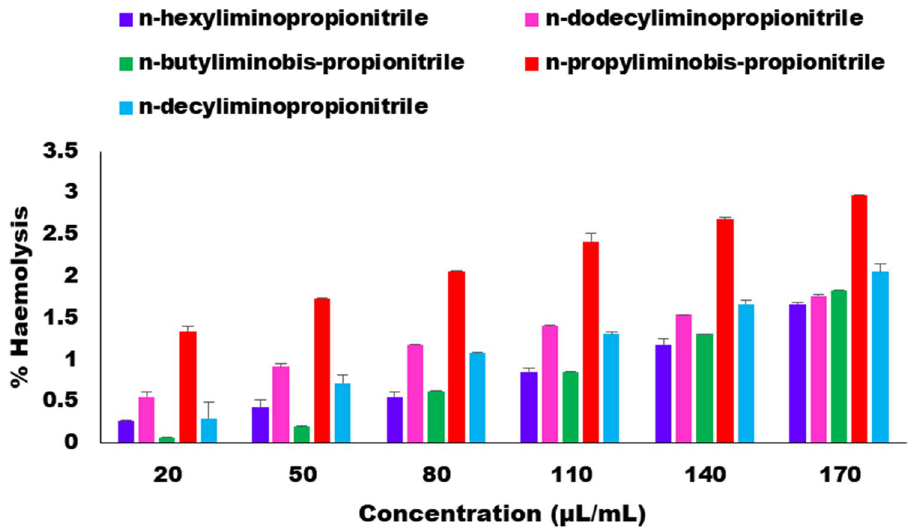
Figure 10. %Haemolysis of acrylonitrile adducts at different concentrations.